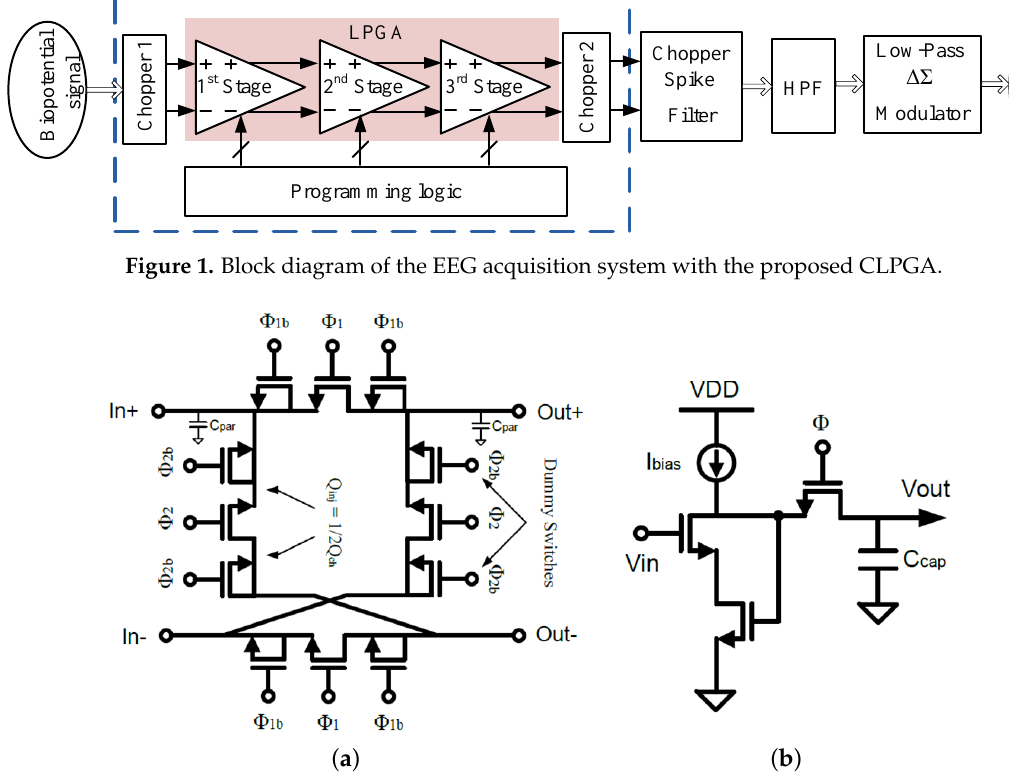
Figure 2. Circuit implementation of: ( a ) Choppers 1 and 2; and ( b ) chopper spike